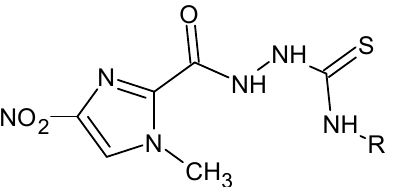
Figure 19. The structure of 1-(1-methyl-4-nitroimidazol-2-oyl)-4-substituted thiosemicarbazide. In 2021, Bekier et al. reported anti-proliferation effects of 4-arylthiosemicarbazides, with a cyclopentane substitution at the N 1 position on the highly virulent RH strain of Toxoplasma gondii . The highest in vitro anti- Toxoplasma activity was found in the meta - iodophenyl derivative (Figure 20). In silico experiments demonstrated inhibitory effects of thiosemicarbazides on tyrosinase (Tyr) activity, and a good correlation was found between the percentage of Tyr inhibition and IC 50 Tg . This may be a new direction in the search for effective drugs against toxoplasmosis [87].